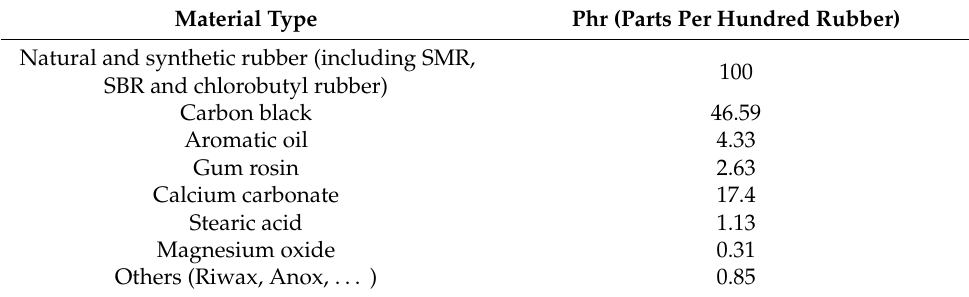
Table 1. Material specifications of the base inner liner master batch compound.